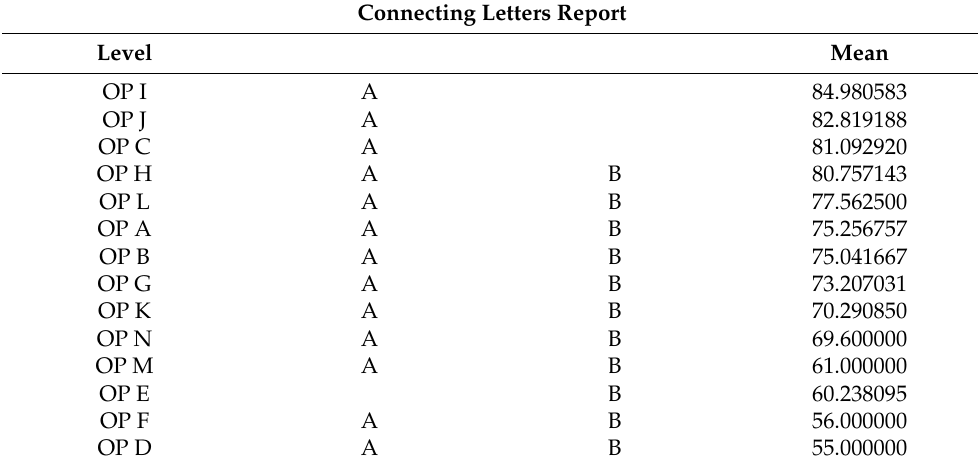
Table 2. The results of grouping operators.